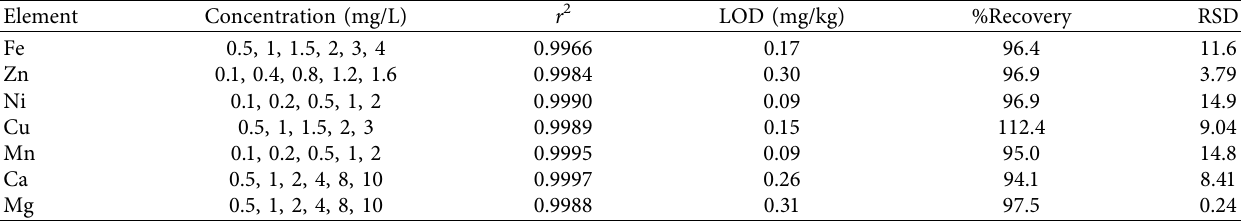
Table 4: Concentrations of standard solutions, coefcient of determination ( r 2 ), limit of detection (LOD), recovery, and the associated relative standard deviation (RSD) values of the method used for the determination of essential metallic elements in the sesame seed samples. Element